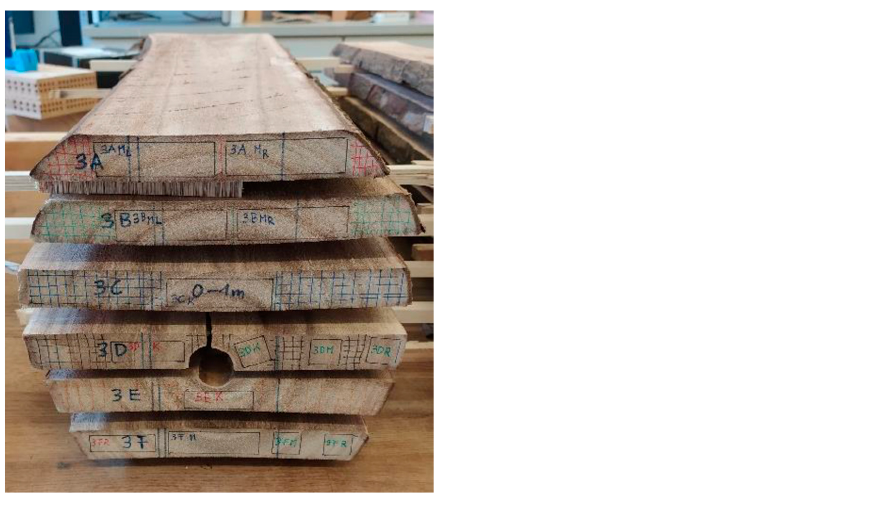
Figure 3. Marking of Paulownia sawn wood in the cross-section prior to the preparation of testing specimens. The diameters of the four logs and cutting direction (parallel and perpendicular to the grain) are presented in Table 1. Table 1. Diameters of Paulownia logs depending on stem height.